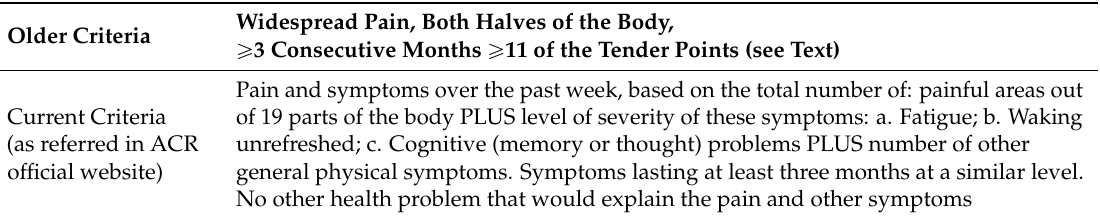
Table 1. ACR criteria needed for fibromyalgia diagnosis and